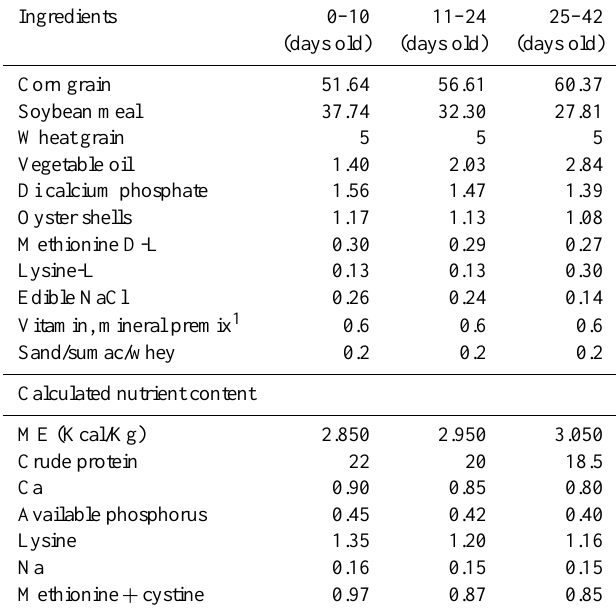
Table 1. Composition (measured in %) of the experimental diets for broiler